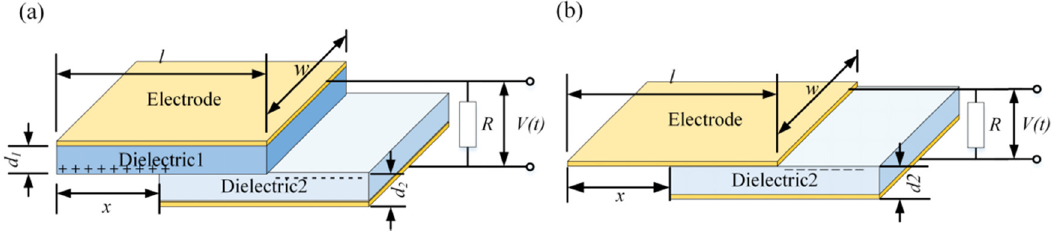
Figure 2: Theoretical model of a sliding - mode TENG: ( a ) dielectric - to - dielectric sliding - mode TENG; ( b ) conductor - to - dielectric sliding - mode TENG [ 41,55 ]